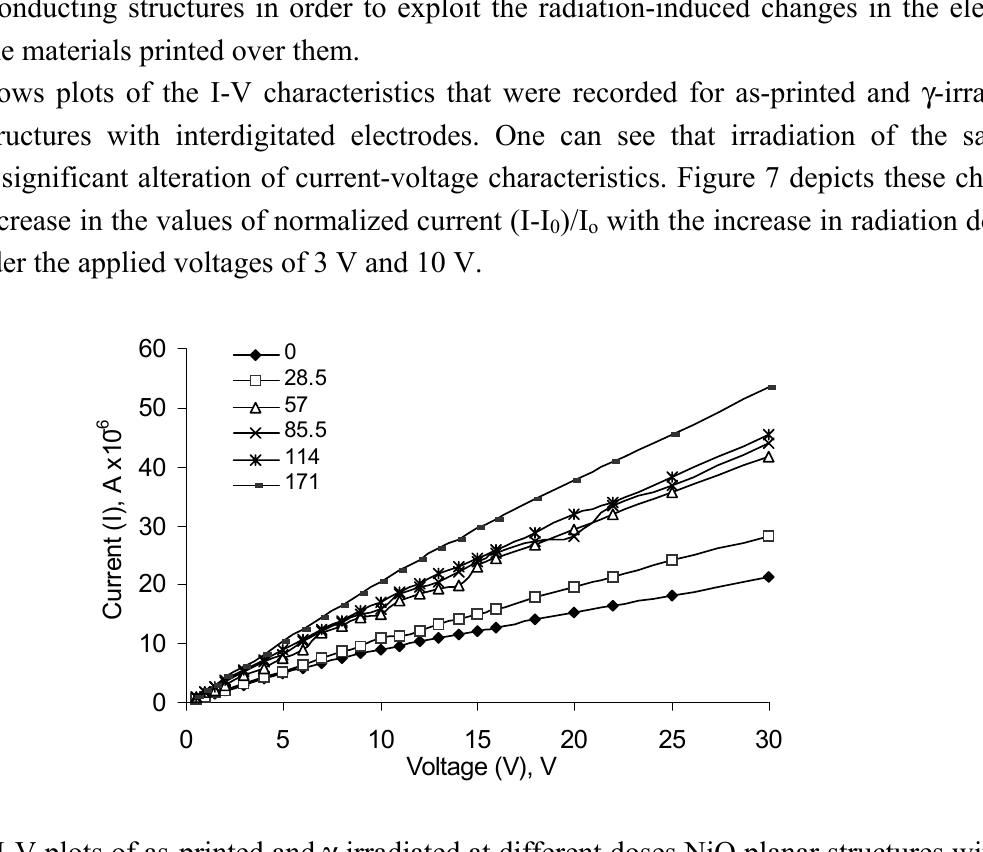
Figure 5. Dependence of normalized current (I-I –9 V and +6 V for NiO/Si pn-junction structures.